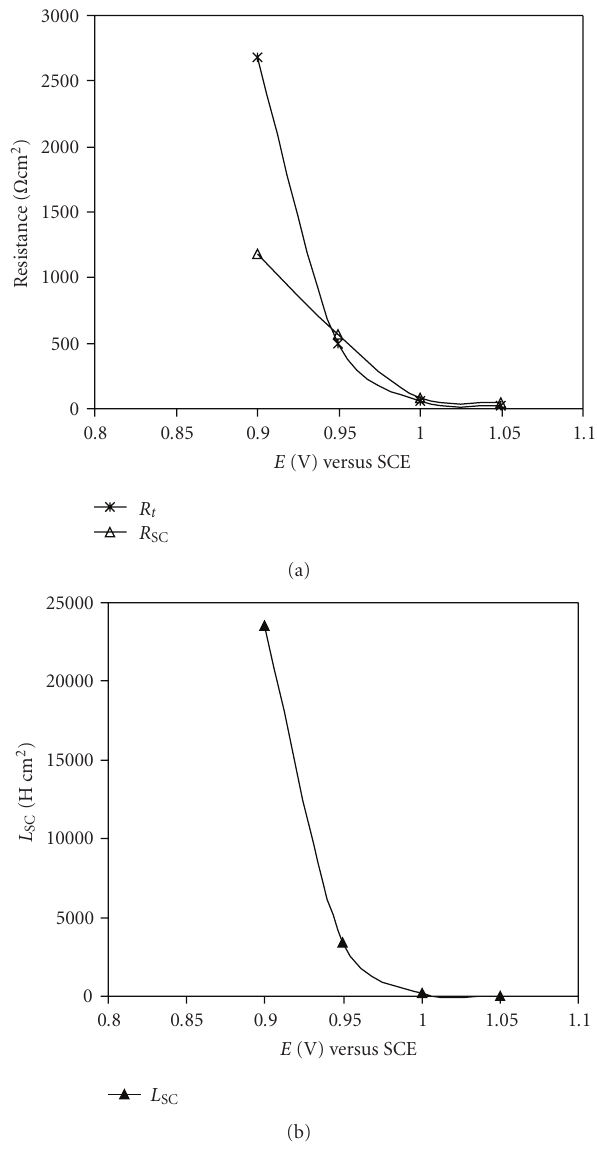
Figure 4: Potential dependences of (a) R t and R SC , (b) L SC . These circuit elements are acquired from equivalent electrical circuit of Figure